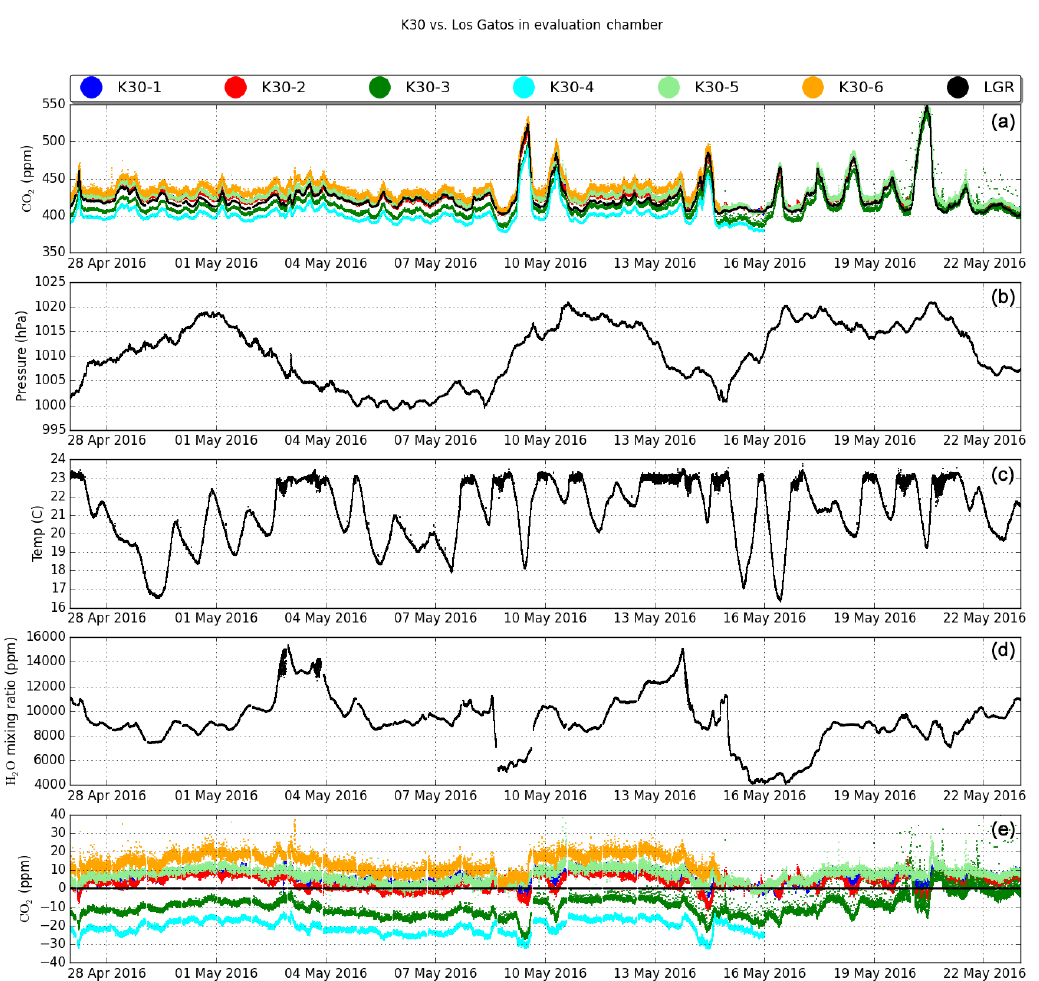
Figure 4. Continuous 1min time series data during the evaluation experiment. (a) CO 2 observed by six K30 sensors as well as the Los Gatos Research Fast Greenhouse Gas Analyzer. (b, c, d) Observed atmospheric pressure, temperature and water vapor mixing ratio, respectively. (e) Difference of each K30 from the Los Gatos